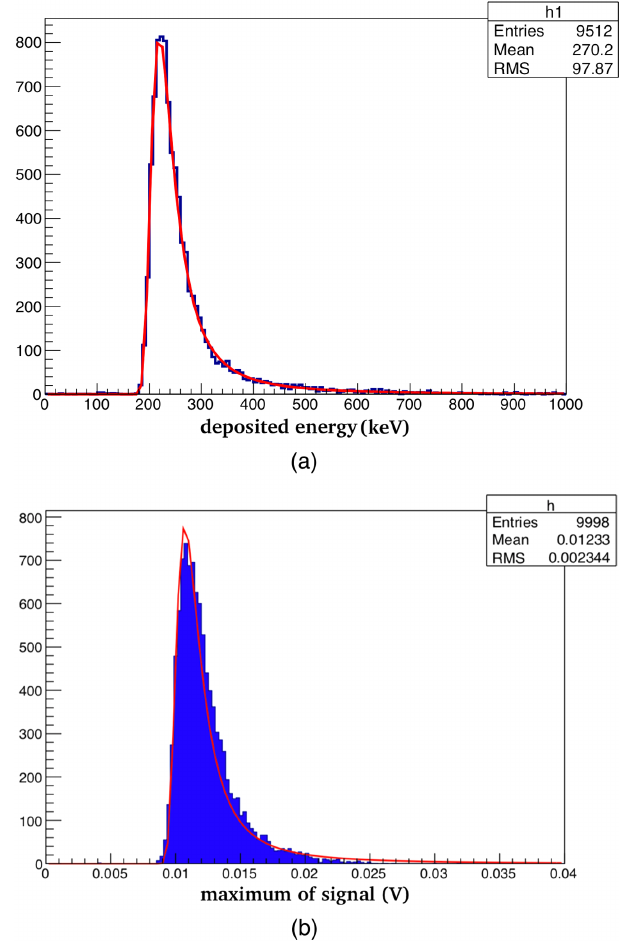
FIG. 1. (a) Simulated Landau distribution of energy deposited by MIPs in 500 μ m DS (b) Experimental Landau distribution in 500 μ m